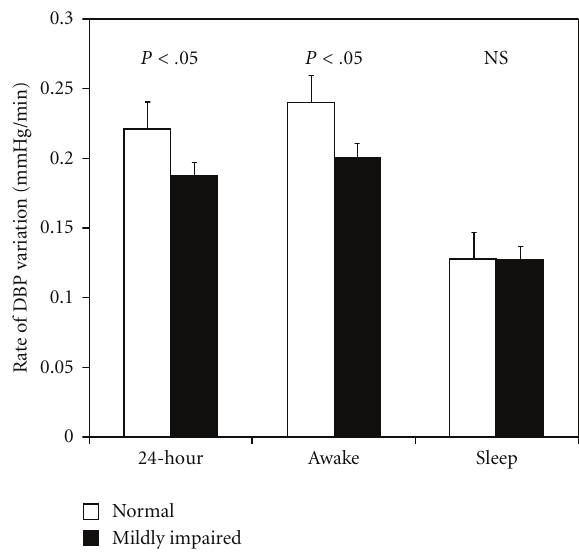
Figure 2: Renal function group di ff erences in rate of DBP variation for awake, sleep, and 24-hour